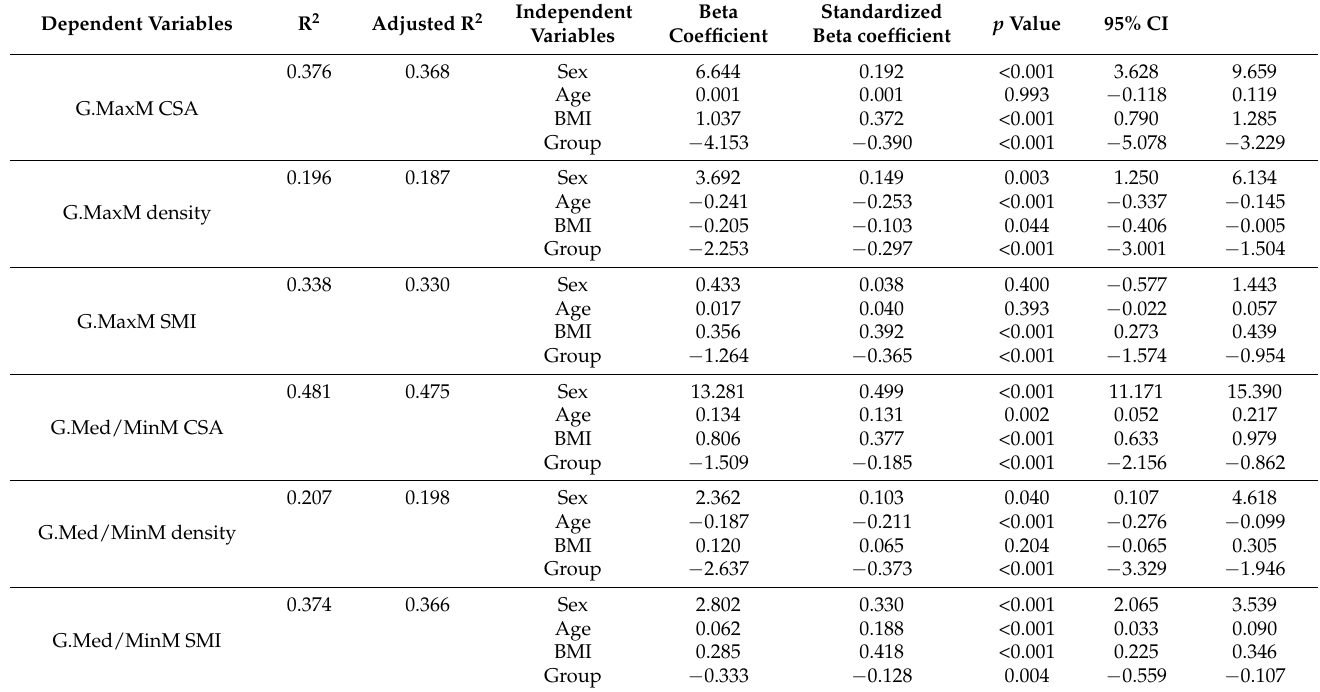
Table 5. The relationship between the severity of hip involvement and muscle parameters, after controlling for sex, age, and